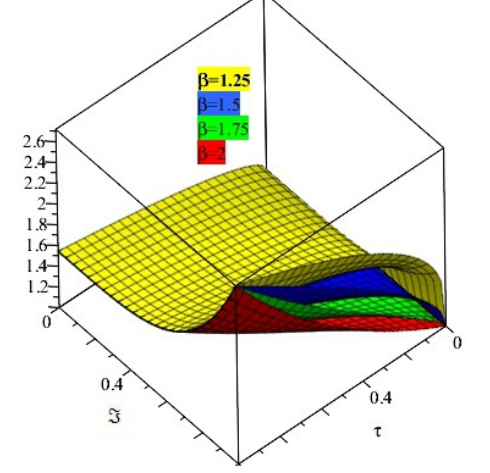
Figure 3. Represents the solution at different fractional order of Example